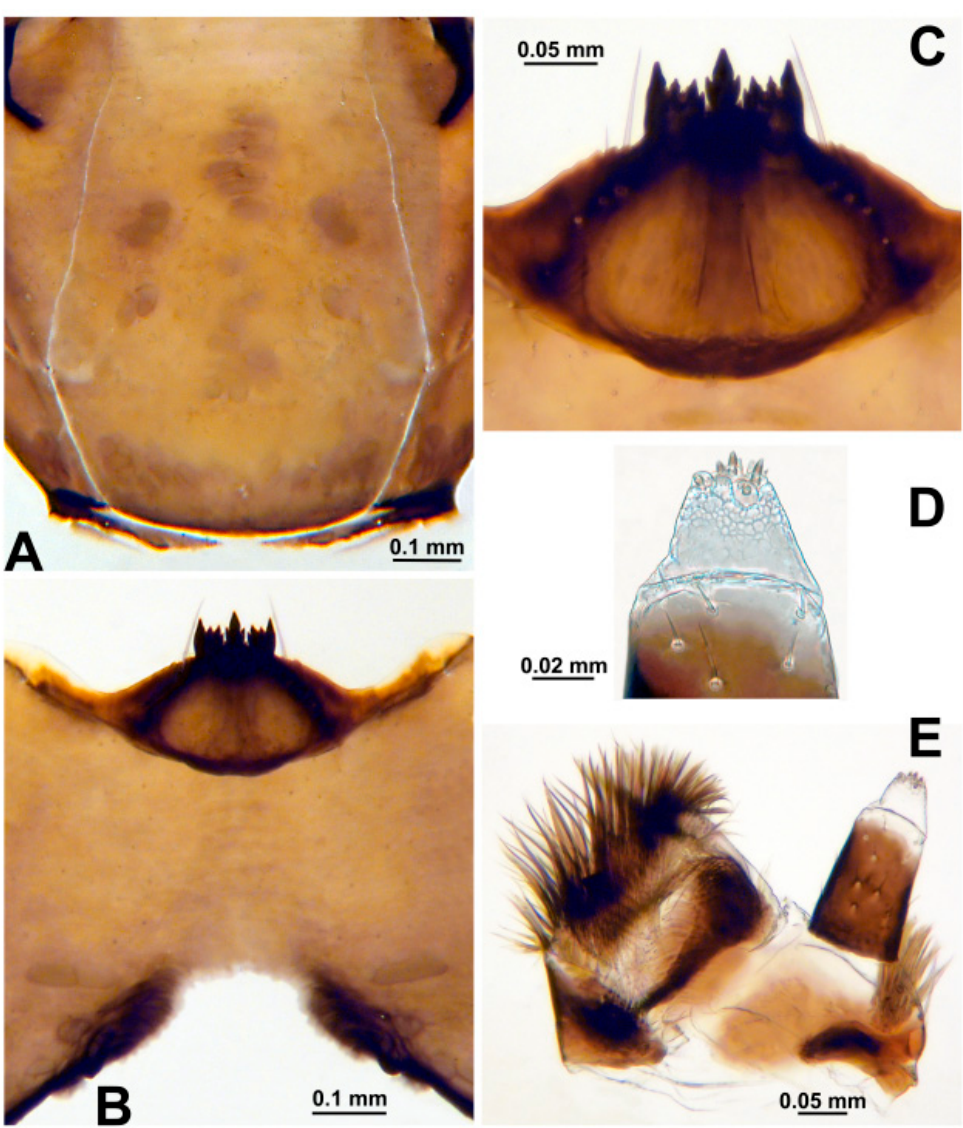
Figure 8. Larva of Prosimulium supernum n. sp. ( A ) Frontoclypeal apotome. ( B ) Head capsule, ventral view. ( C ) Hypostoma, ventral view. ( D ) Maxillary palp, apex. ( E ) Maxilla with maxillary palp, lateral view.